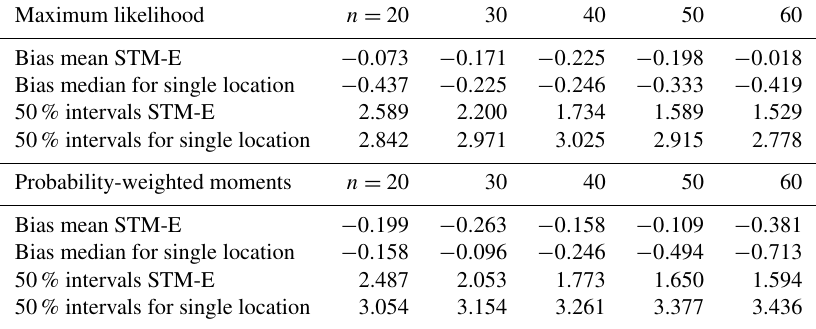
Table 1. Performance of STM-E and single-location analysis in estimation of the bias and uncertainty of the 500-year return value, relative to empirical estimates from the full synthetic cyclone data, for analysis sample sizes of 20, 30, 40, 50, and 60 all extracted from the 200-year data set. Bias B is assessed as the average difference (over the iso-depth contour and line transect analyses) between the mean STM-E (or single-location) estimate and the return value estimate from the full cyclone database. Similarly, uncertainty U is assessed in terms of the average width of the 50% uncertainty band of the STM-E (or single-location) estimate. Maximum likelihood n = 20 30 Bias mean